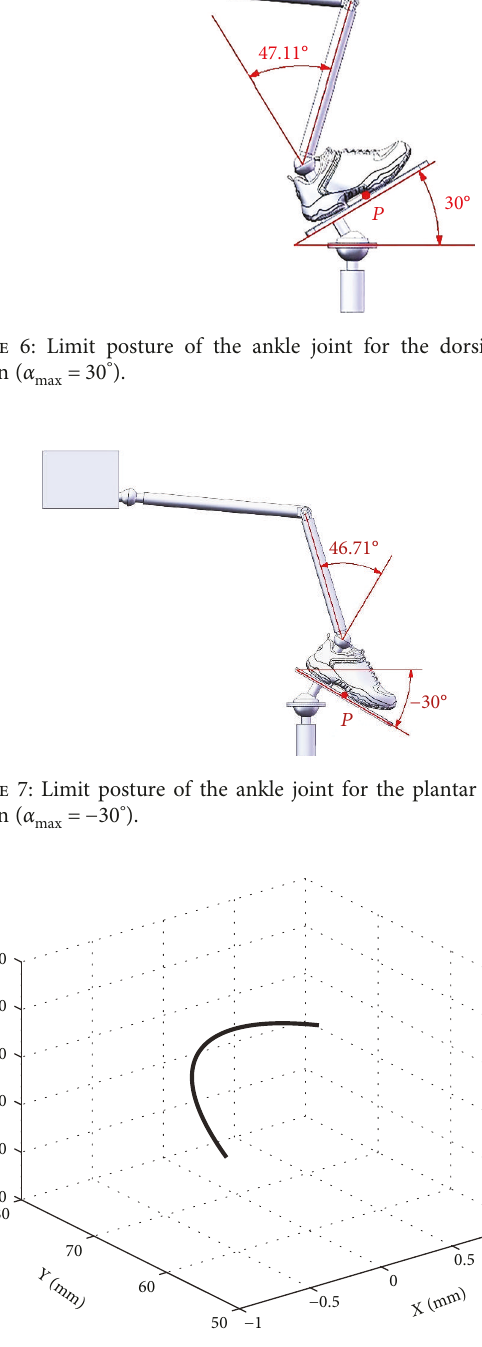
Figure 8: Working space for the dorsi fl exion/plantar fl exion